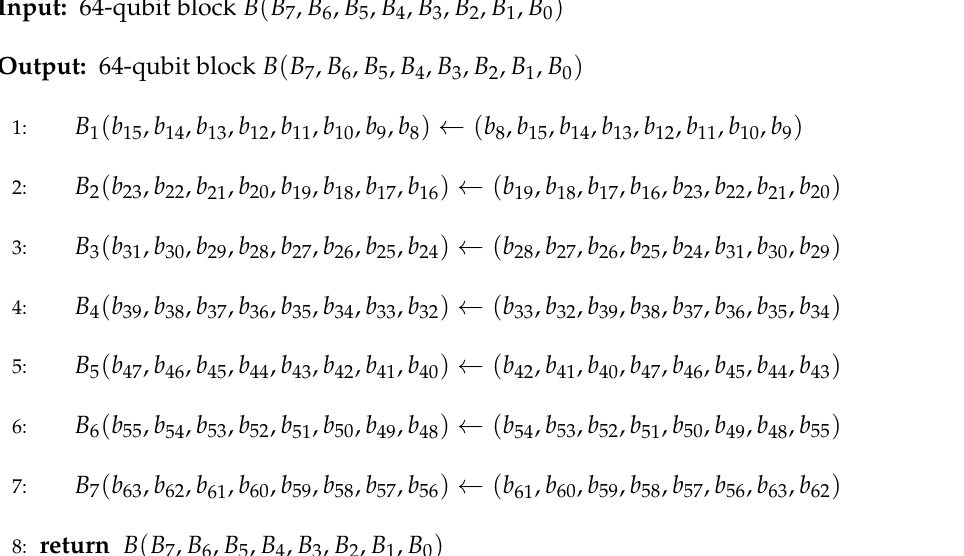
Algorithm 7 Relabeling qubits for block B .